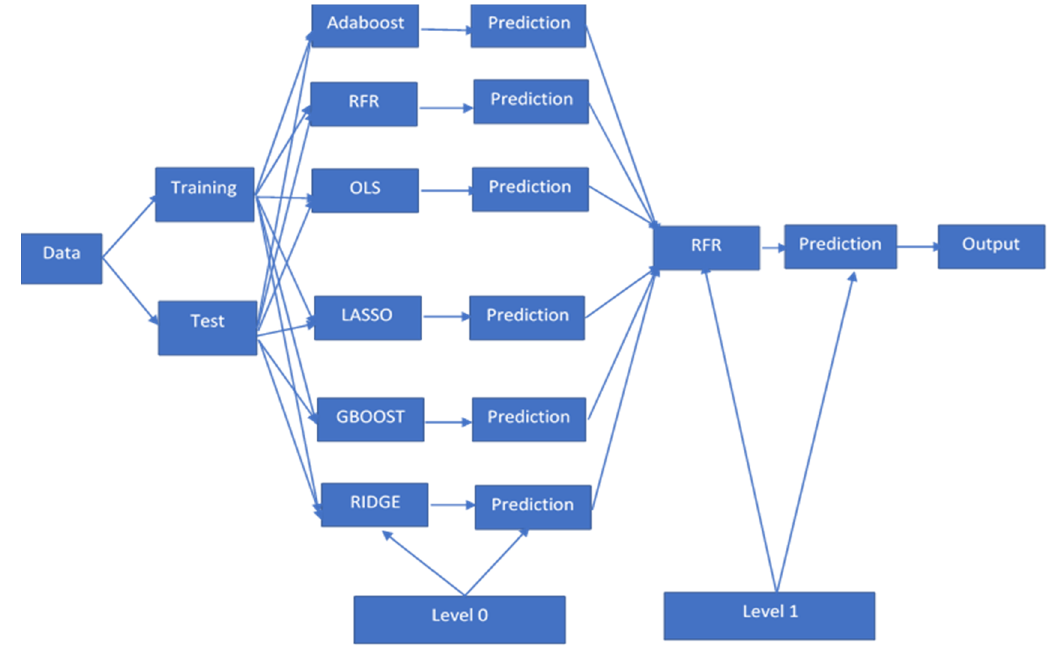
Figure 1. Architecture of the Proposed Stacking Ensemble Learning (SEL) Systems.